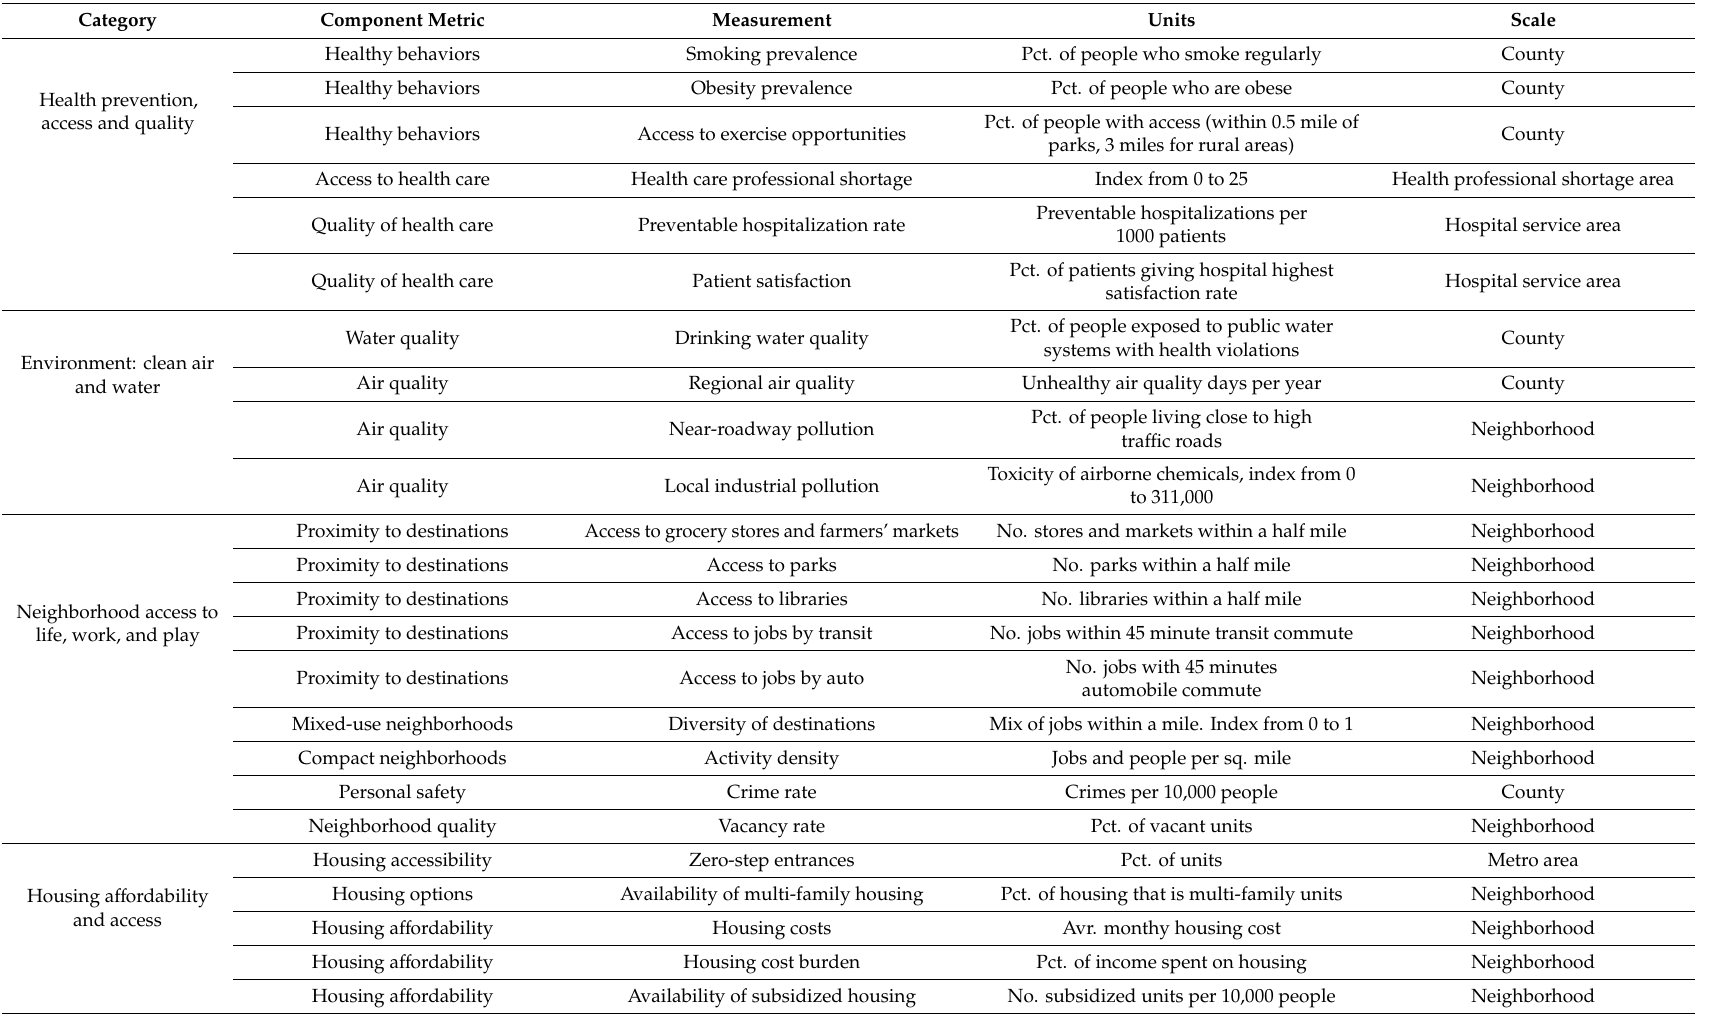
Table A1. Component Metrics of AARP Livability Index